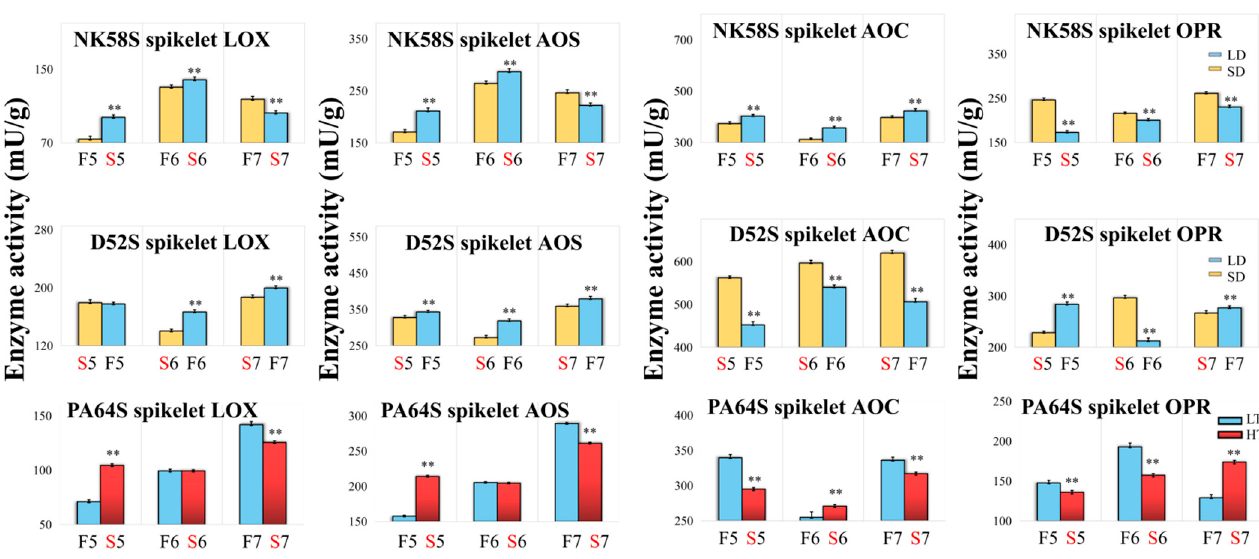
Figure 2. Four key enzyme activities of JA synthesis pathway in D52S, NK58S and PA64S spikelets by photoperiod and temperature treatment. The LD/SD and HT/LT treated plants are columnar with blue/yellow and red/blue color, respectively. Data are shown as mean ± standard deviation ( n = 3). Asterisks indicate significant differences between sterile and fertile plants revealed by Student’s t -test (**, p < 0.01). LD, long-day cycle; SD, short-day cycle; HT, high temperature; LT, low temperature; S/F, sterile/fertile plants; 5/6/7, 5th/6th/7th-stage; LOX, lipoxygenases; AOS, allene oxide synthase; AOC, allene oxide cyclase; OPR, oxophytodeinoate reductase.